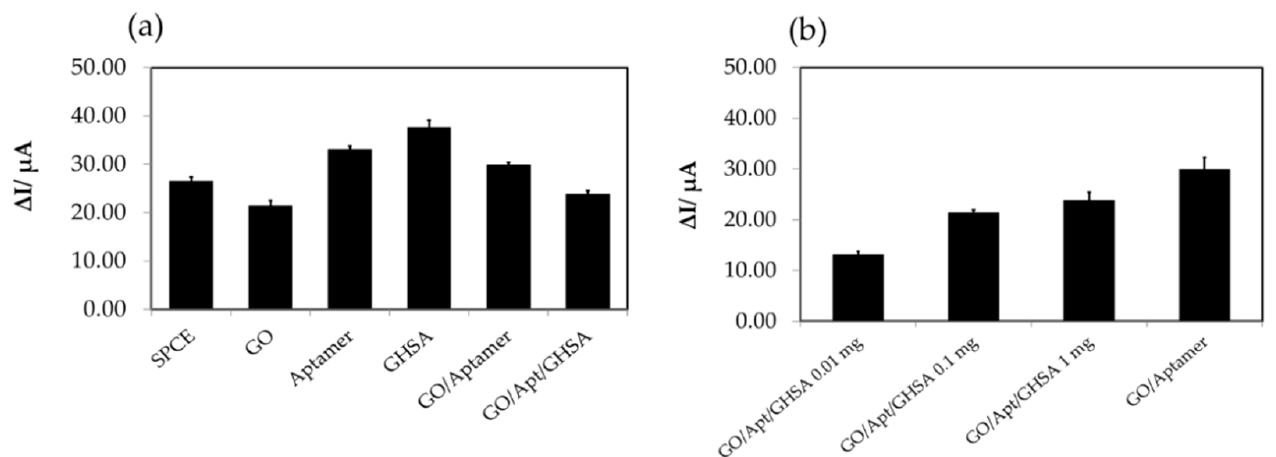
Figure 3. ( a ) The electrochemical characteristics of the components in the developed electrochemical aptasensor using unlabeled aptamer. ( b ) The current changes ( Δ I) of different GHSA concentrations using the unlabeled aptasensor. The SPCE bar represents the Δ I of the bare electrode, the GO bar represents Δ I after adding free GO on the electrode surface, the aptamer bar represents Δ I after adding free aptamer on the electrode surface, the GHSA bar represents Δ I after adding GHSA on the electrode surface, the GO/aptamer bar represents Δ I after adding the GO ‐ aptamer complex on the electrode surface, and the GO/Apt/GHSA bar represents Δ I after adding the mixture of GO ‐ aptamer and GHSA on the electrode surface.